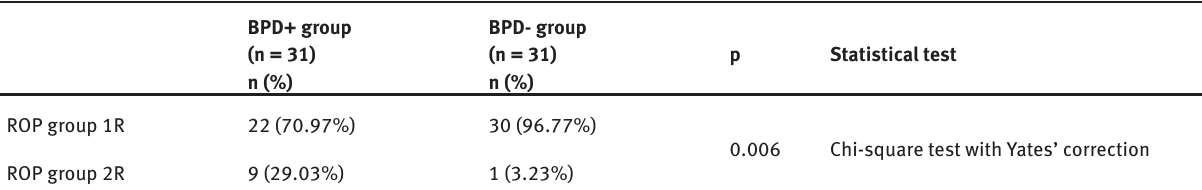
Table 1: Correlation of the incidence and severity of ROP in neonates with BPD+ (study group) and BPD- (control group) in the population of